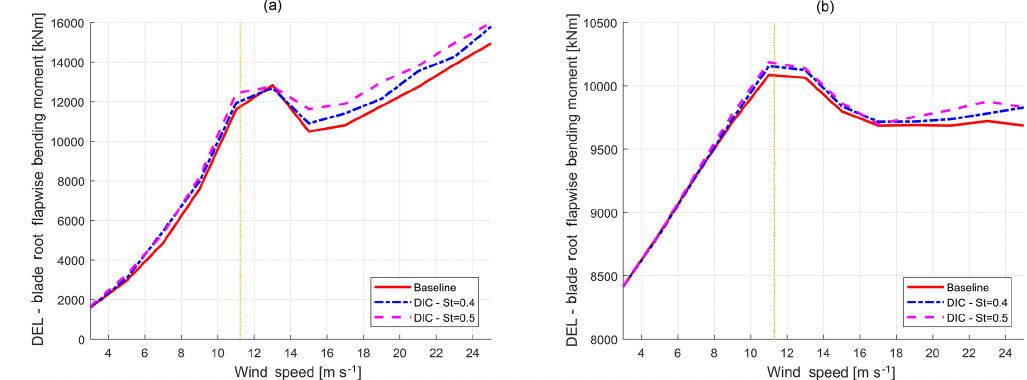
Figure 8. Comparison between blade root flapwise (a) and edgewise (b) DEL of the baseline (solid red) and DIC with St = 0 . 4 (dash–dotted blue) and St = 0 . 5 (dashed magenta) as functions of mean wind speed. The dashed yellow line indicates the rated wind velocity. Typically, DIC will only be implemented at below-rated inflow velocities.